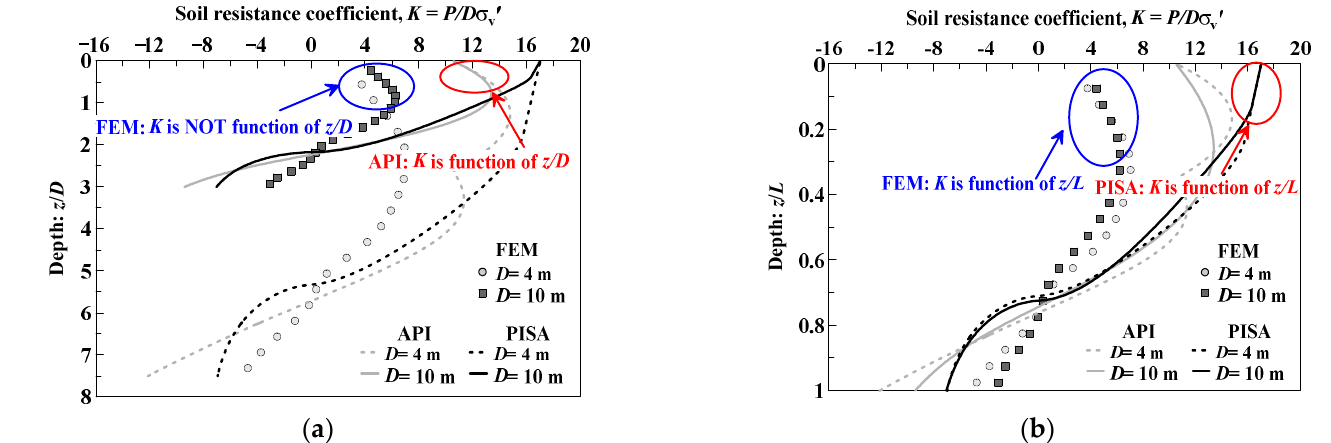
Figure 10. Soil resistance coefficient profiles at 4 degrees and under loading eccentricity in 65% relative density sand against: ( a ) z/D , ( b ) z/L .